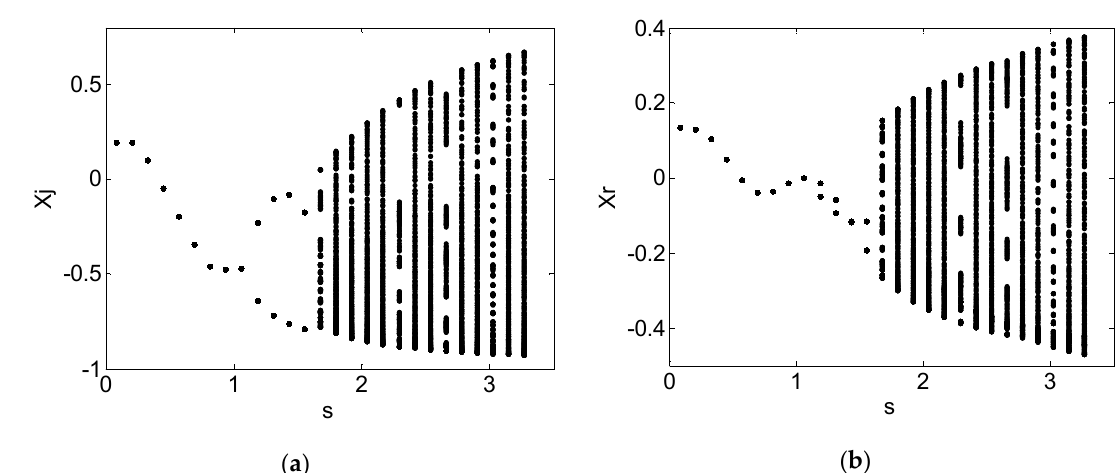
Figure 4. Bifurcation diagram of the axis and floating ring when λ = 0.035: ( a ) bifurcation diagram of journal; ( b ) bifurcation diagram of floating ring.